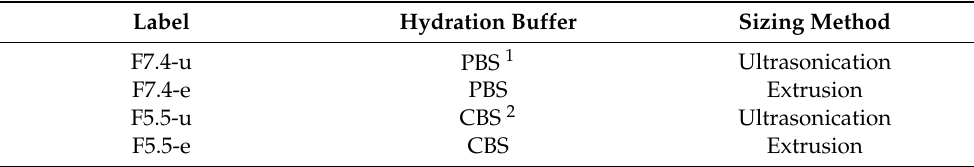
Table 1. Liposomal formulations under study.